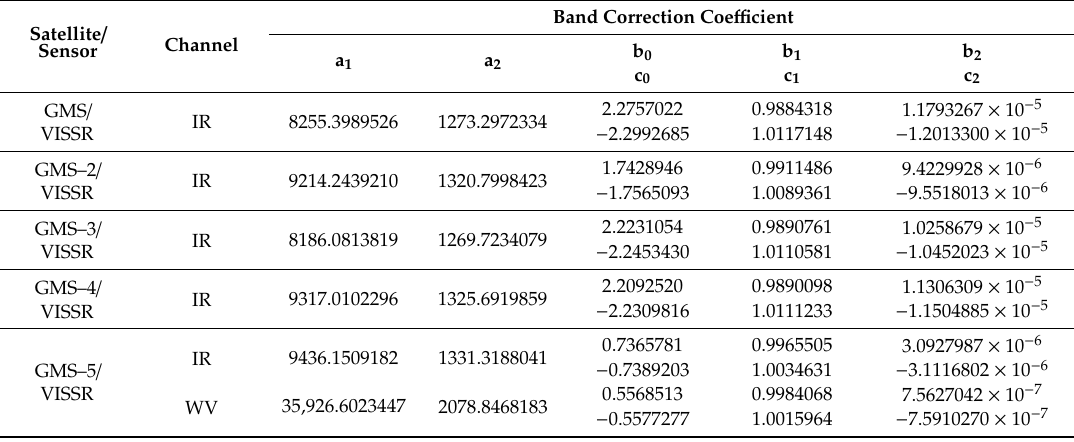
Table A5. The parameters of the Sensor Planck Functions for IR and WV channels on old JMA